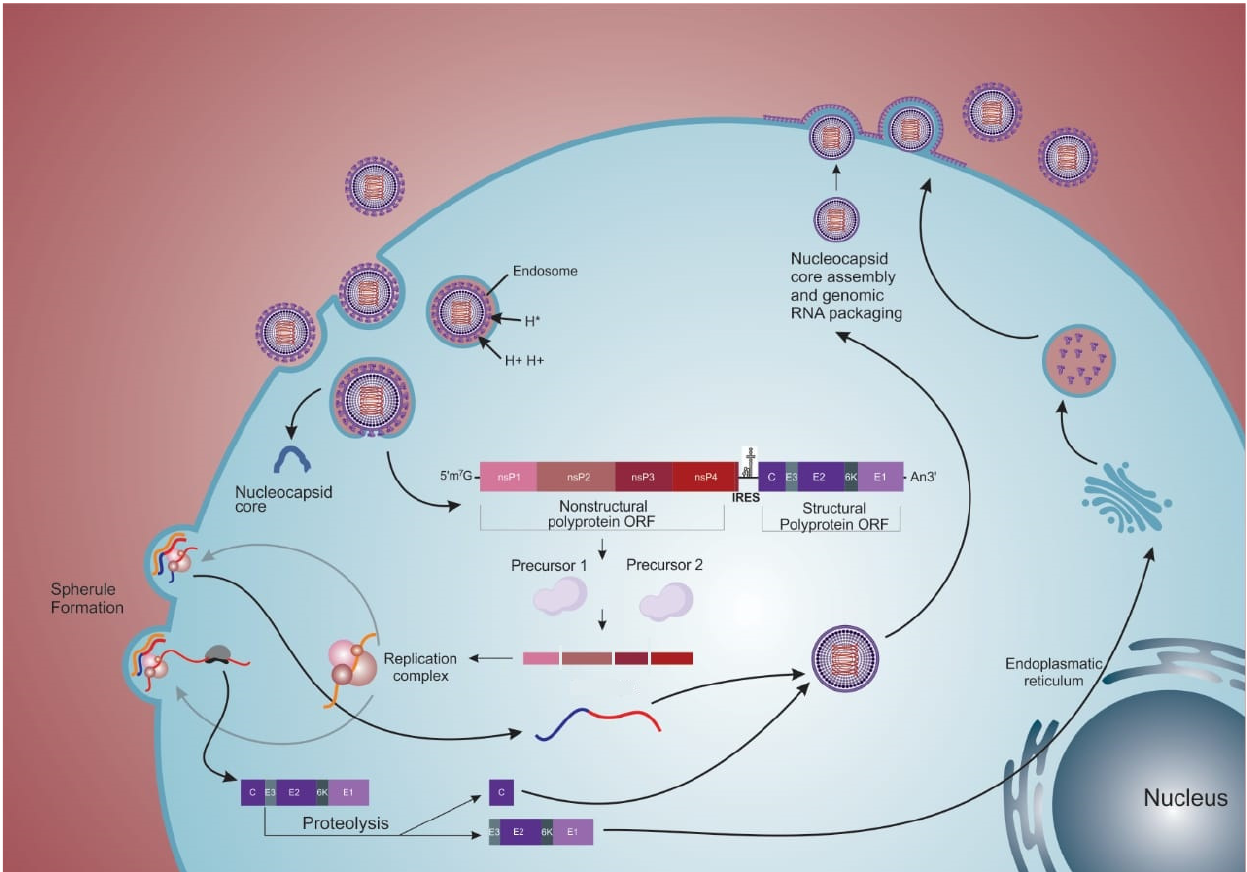
Figure 2. The replicative cycle of MAYV. Cell entry of MAYV is mediated by endocytosis and occurs via a clathrin-coated vesicle or, alternatively, caveolin. Internalization begins by binding the E2 virus with host cell receptors, possibly Mxra8. After endosome formation, acidification of its interior occurs, leading to structural changes in the viral envelope, exposing the E1 protein and promoting cell membrane and virus fusion. As a result, the nucleocapsid and viral genome are released into the cell’s cytoplasm. The genome is recognized by ribosomes, and a pair of nsP precursors is synthesized from the generated viral mRNA. The replication complex (RC) produced from the interaction of nsP is among the precursors. The RC catalyzes the synthesis of a negative-strand RNA that will, in turn, be the template for generating genomic (49S) and subgenomic (26S) RNA. The 26S structural polyprotein is generated, and the capsid protein is released and surrounds the 49S RNA through the action of the autoproteolytic serine protease, assembling the nucleocapsid. The remainder of the polyprotein is directed to the processing and maturation of E2 glycoproteins (through the E2 precursor protein; pE2) and E1 glycoproteins in the endoplasmic reticulum and Golgi complex. The mature glycoproteins will associate with and be transported to the cell membrane. The presence of the nucleocapsid in the membrane allows the recruitment of E1, initiating the process of viral assembly and the release of new MAYV and other alphavirus progenies through the cell membrane.